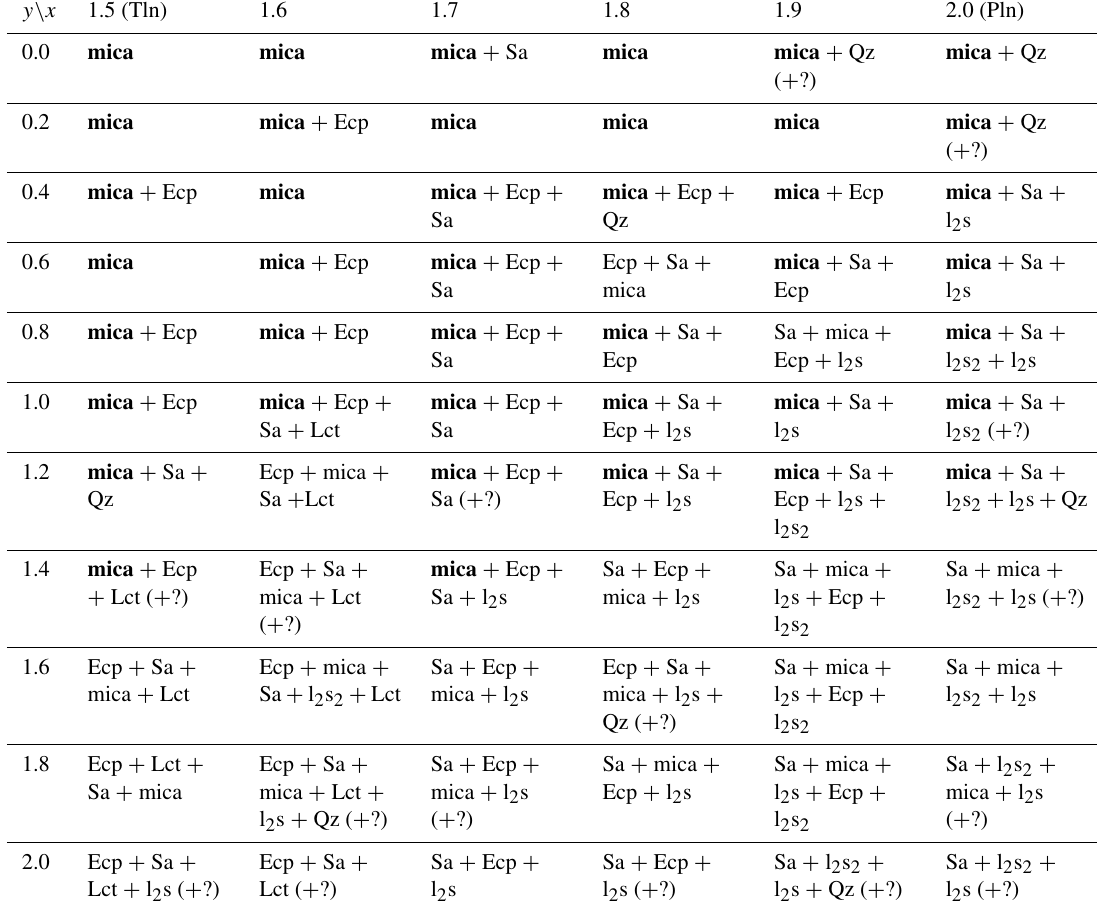
Table 2. List of phases as determined by X-ray diffraction for the nominal compositions of the reaction mixtures along the polylithionite (Pln)–trilithionite (Tln) join. The various phases are listed in order of relative quantity. Products with mica as major phase are printed in bold letters. Symbols – Qz: SiO 2 (quartz), Ecp: eucryptite, Sa: sanidine, l 2 s: Li 2 SiO 3 , Lct: leucite, l 2 s 2 : Li 2 Si 2 O 5 (lithium disilicate). Some impurity phases which could not be identified are marked with